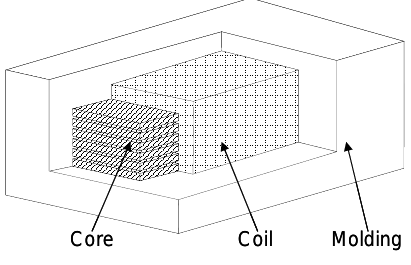
Figure 2. Structure of